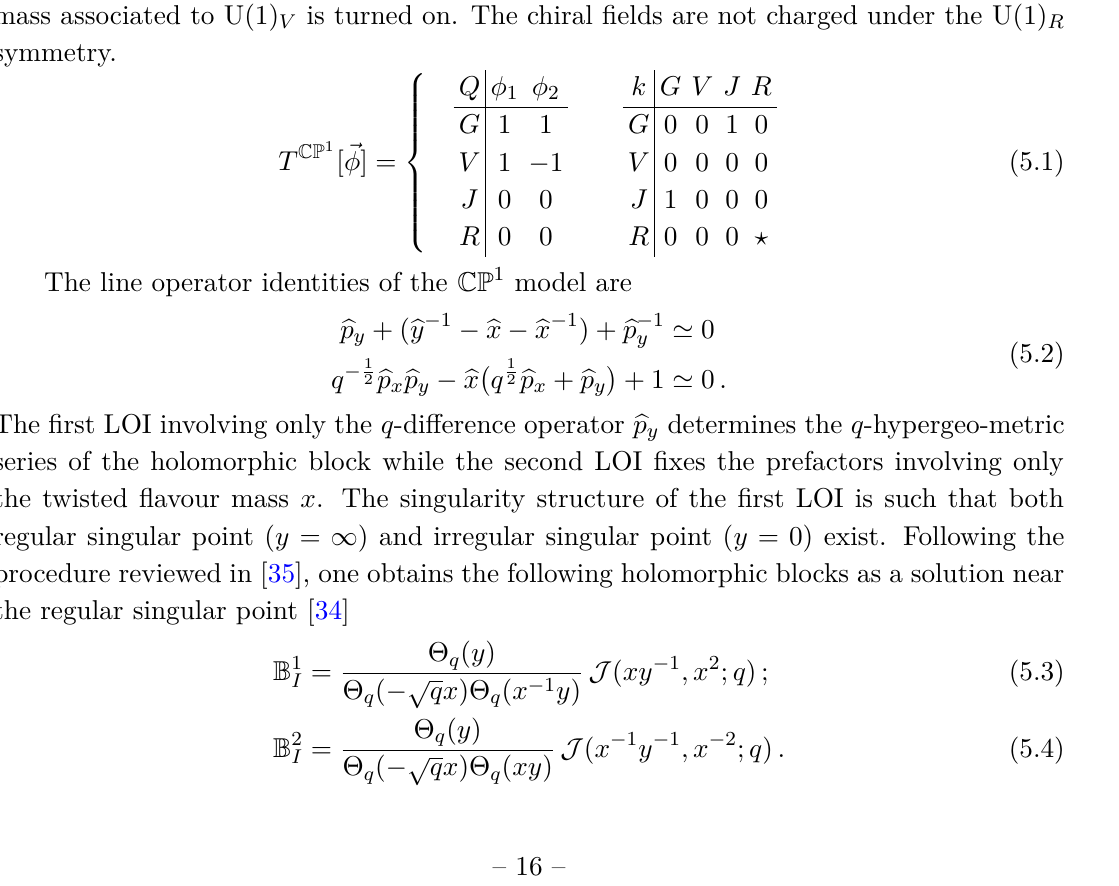
and V : x − 1 − 1 1 → x 2 → qx 1 2